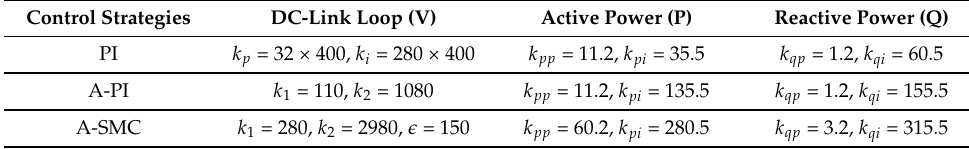
Table A2. Control gains without PV power feedforward